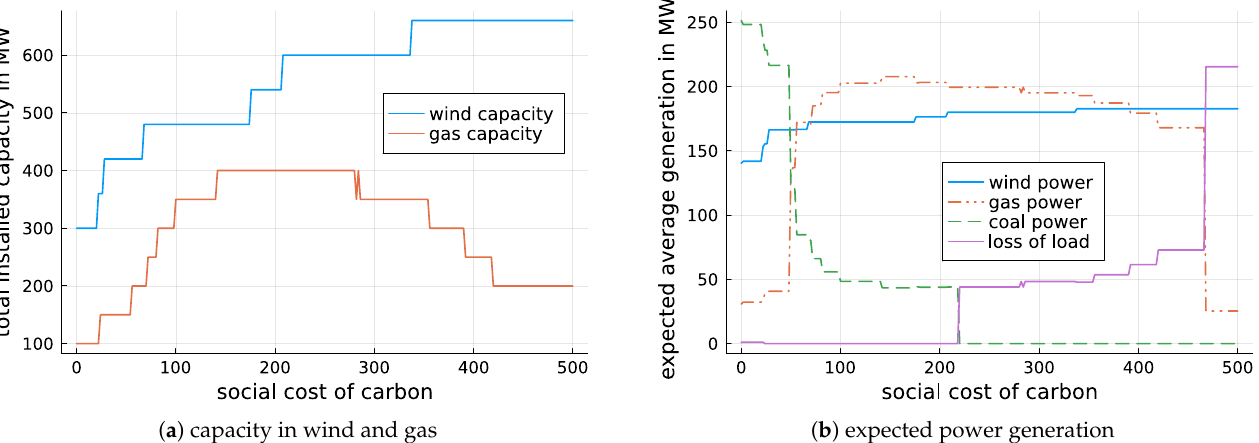
Figure 5. The cumulative capacity installments of both wind- and gas turbines with respect to SCC are shown in ( a ); ( b ) shows the expected generation of each asset (including loss of load) under each GHG-emissions